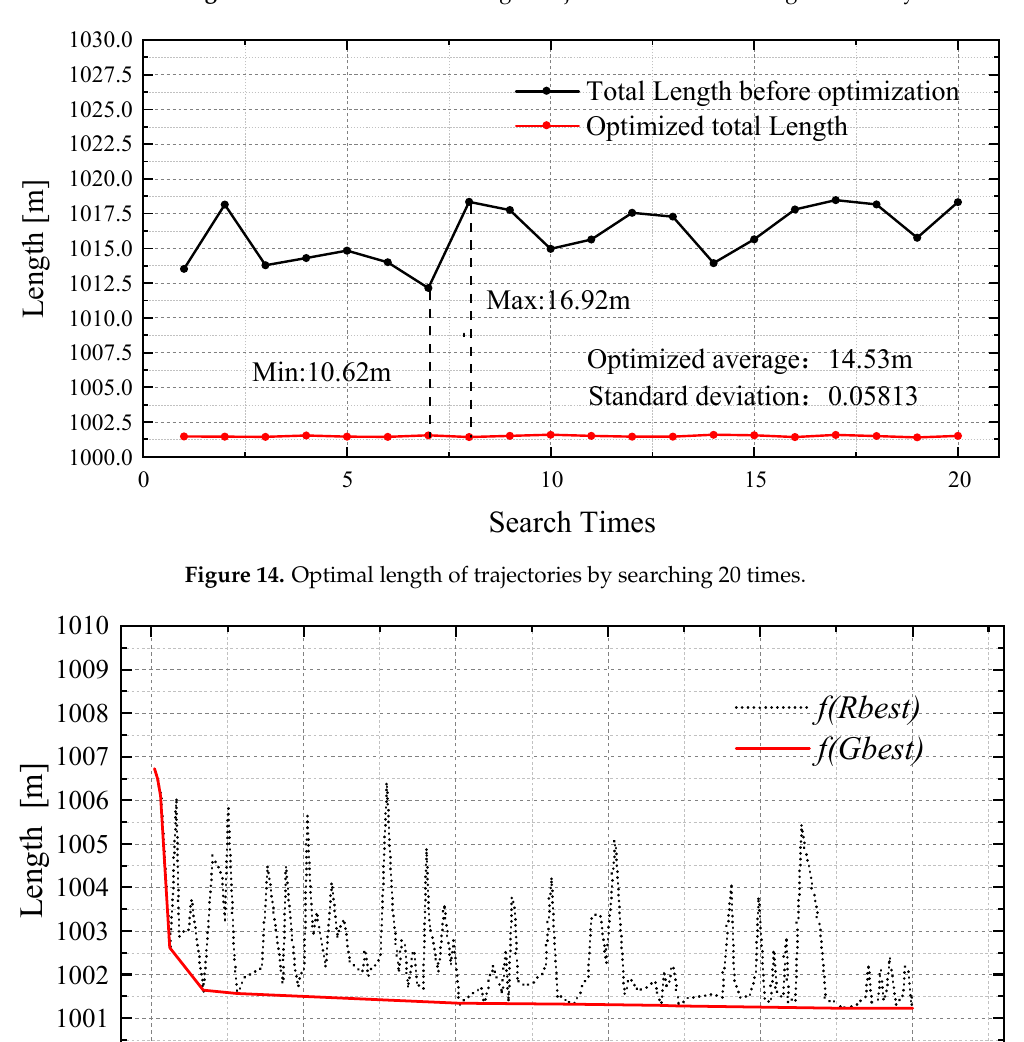
Figure 13. The shortest total length trajectories after searching 20 times by IRMO.